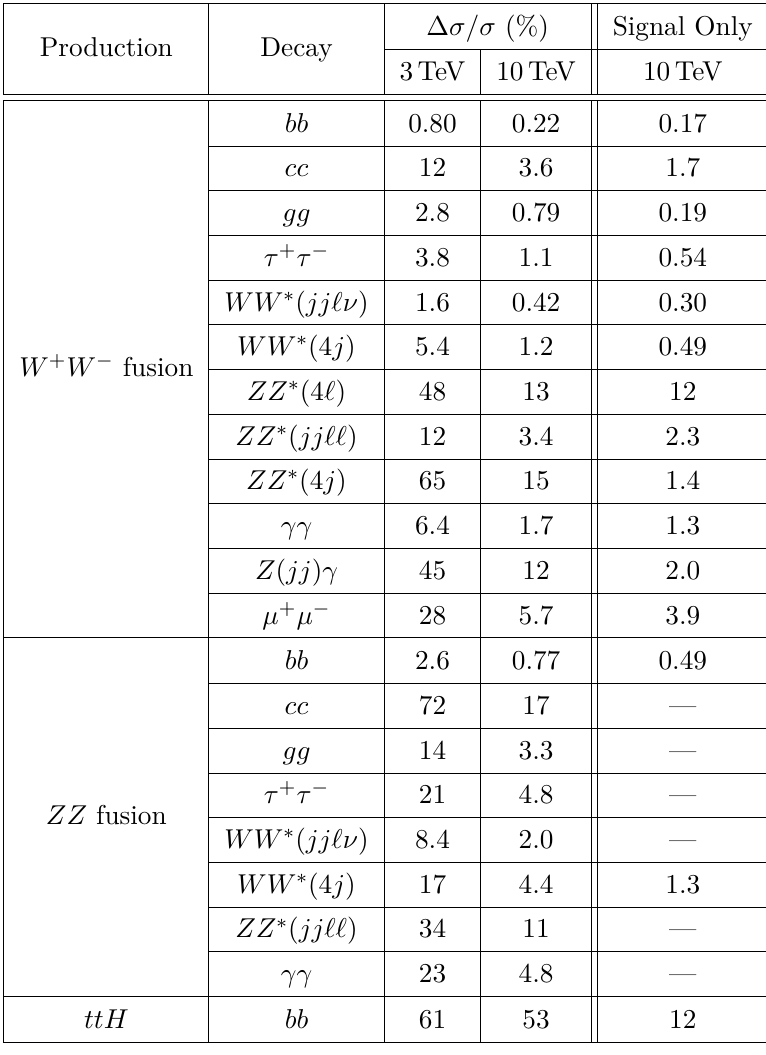
Table 10 . Signal precision for selected Higgs production channels at 3 TeV and 10 TeV muon colliders using Delphes fast simulation including physics backgrounds with a hypothetical forward muon detector up to | η | < 6 . The signal-only results from [14] are shown for comparison, with a typo in the µ + µ − channel corrected. t ¯ tH includes all of s -channel, ZZ fusion, and W + W − fusion production